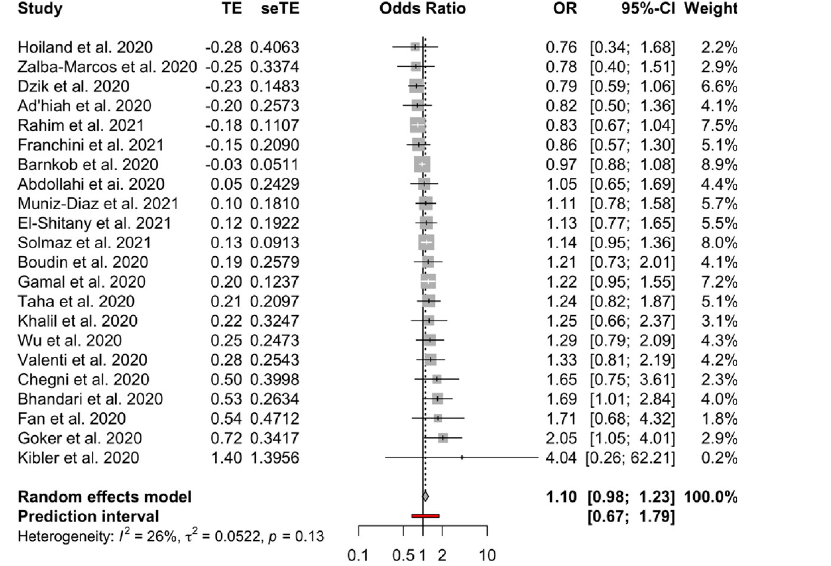
Fig 3. Forest plots for the ABO gene comparison of A vs. B group.